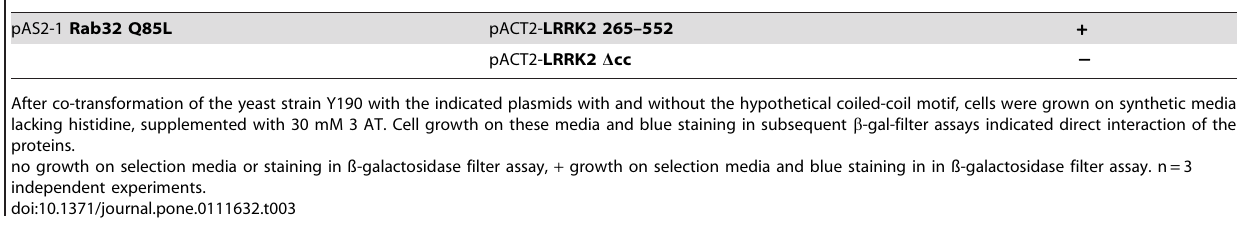
Table 3. Mapping of Rab32 binding motif within LRRK2 aminoterminus.